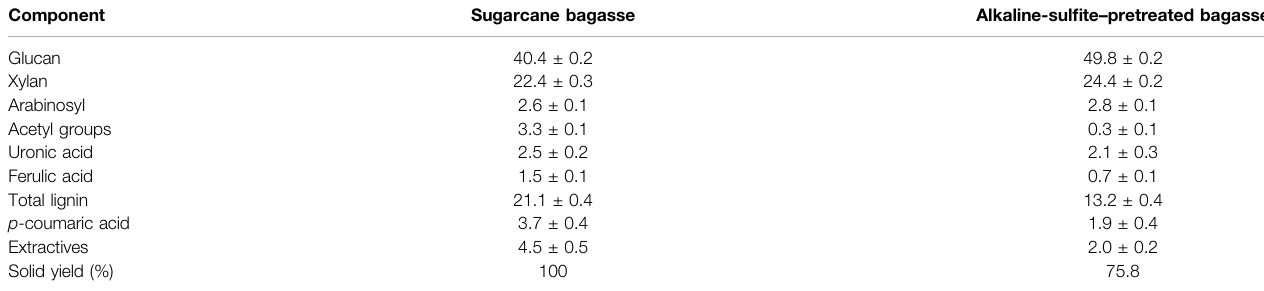
TABLE 1 | Chemical composition (g/100 g, dry matter) of the original and alkaline-sul fi te – pretreated sugarcane bagasse used in the current experiments. Component Sugarcane bagasse